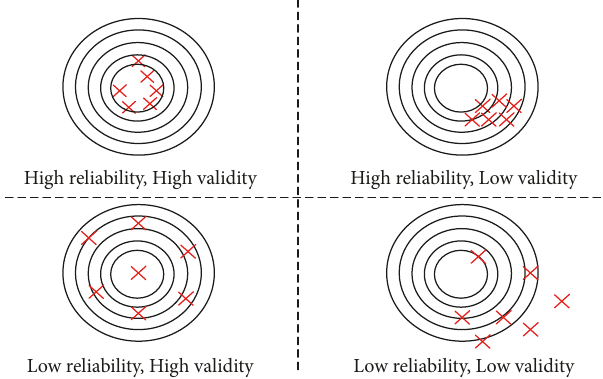
Figure 7: Concept of validity versus reliability